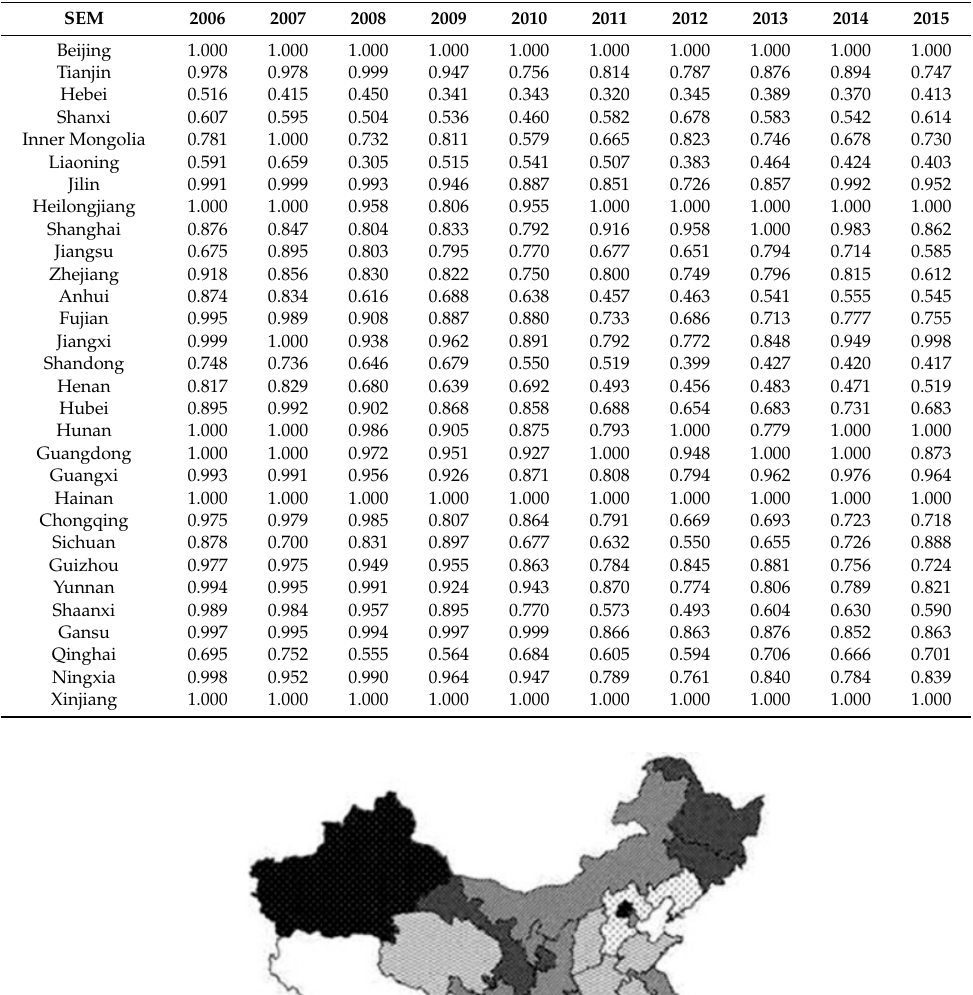
Table 5. Scale e ffi ciency under managerial disposability from 2006 to 2015.